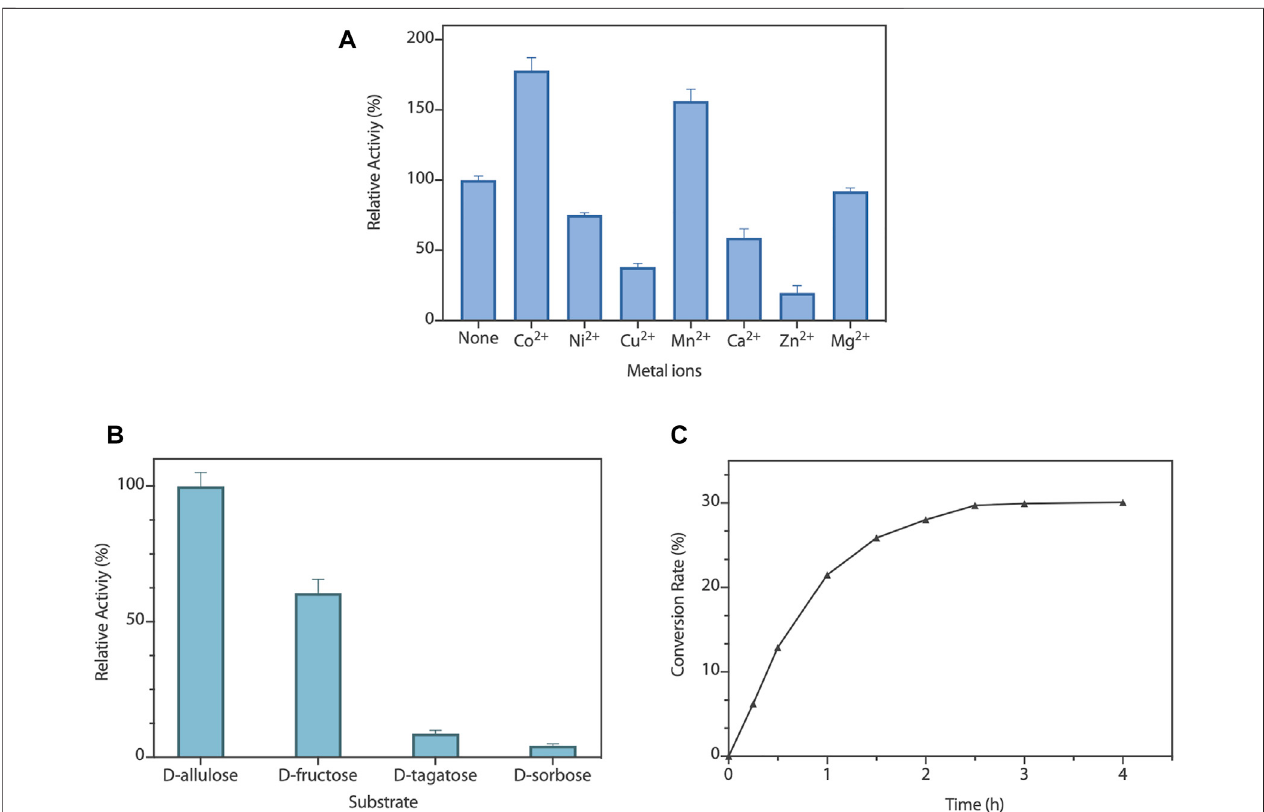
FIGURE 4 | (A) Effect of metal ions on RpDAE activity. (B) Substrate speci fi city of RpDAE. (C) Time course of bioconversion from D-fructose to D-allulose by RpDAE.